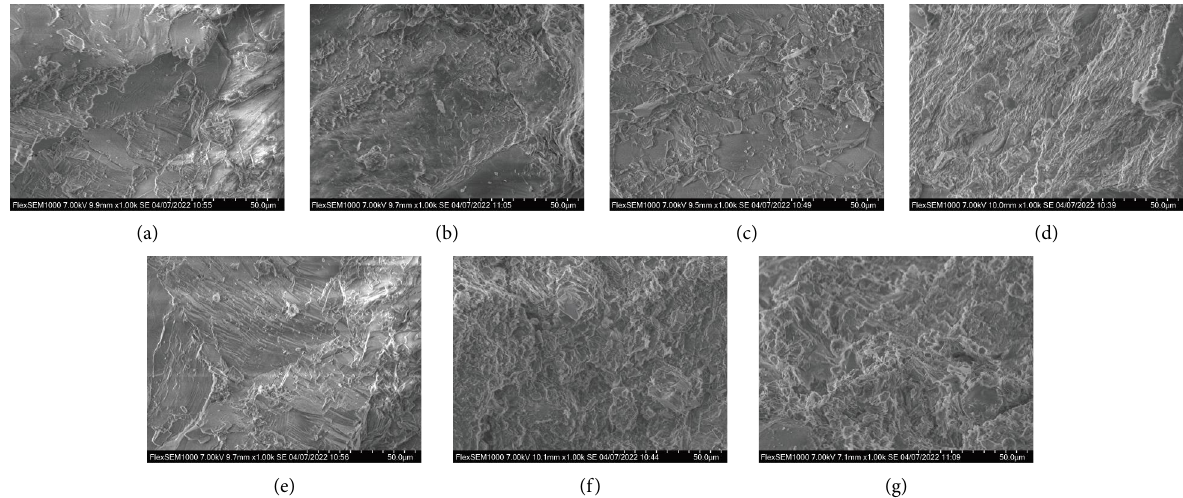
Figure 10: SEM images of specimens after corrosion in various pH solutions. (a) Uncorroded. (b) pH � 7 (c) pH � 8. (d) pH � 9. (e) pH � 10. (f) pH � 11. (g) pH � 12.